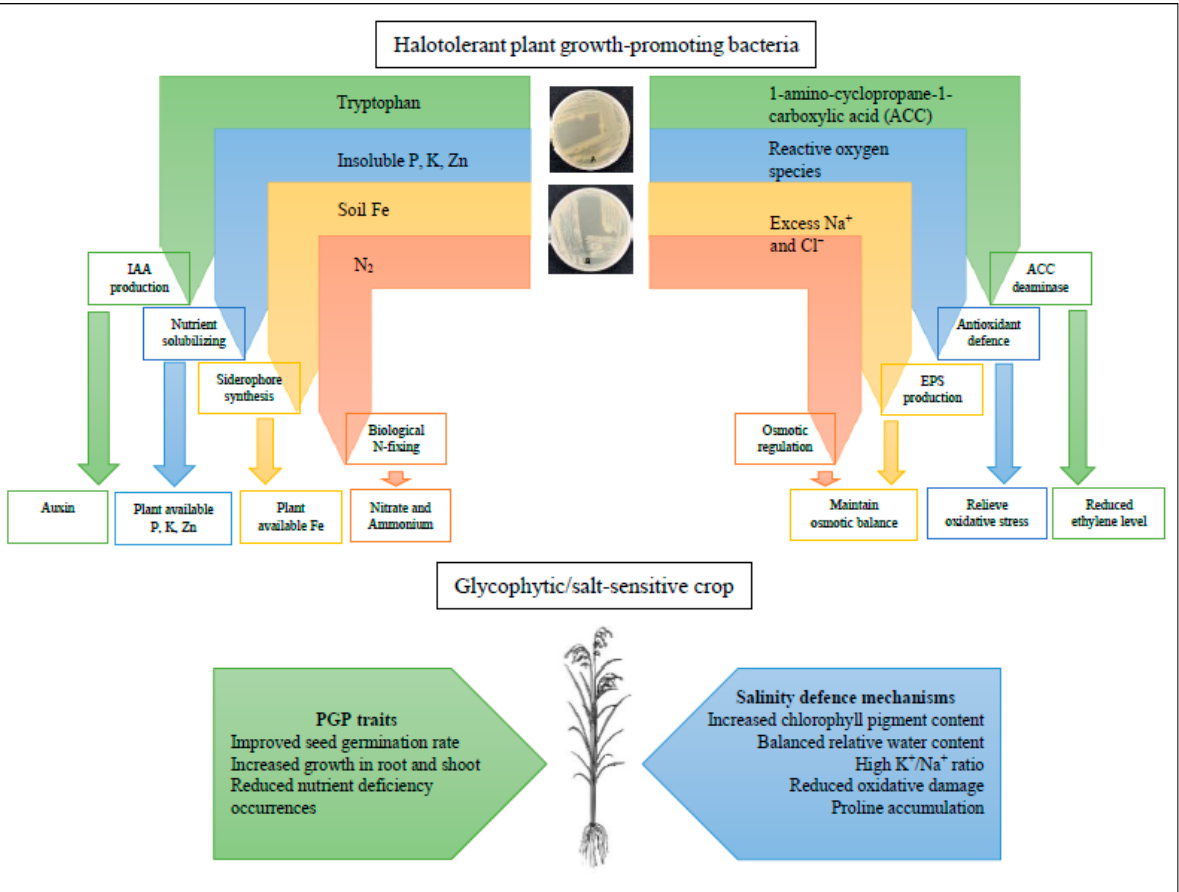
Figure 1. The roles of potential halotolerant plant growth-promoting bacteria (HT-PGPB) with plant growth (PGP) and salinity defense mechanisms to alleviate salinity stress in glycophytic crops. The depicted plates are potential HT-PGPB (rhizobacteria and endophytes, respectively) isolated from native halophytes.